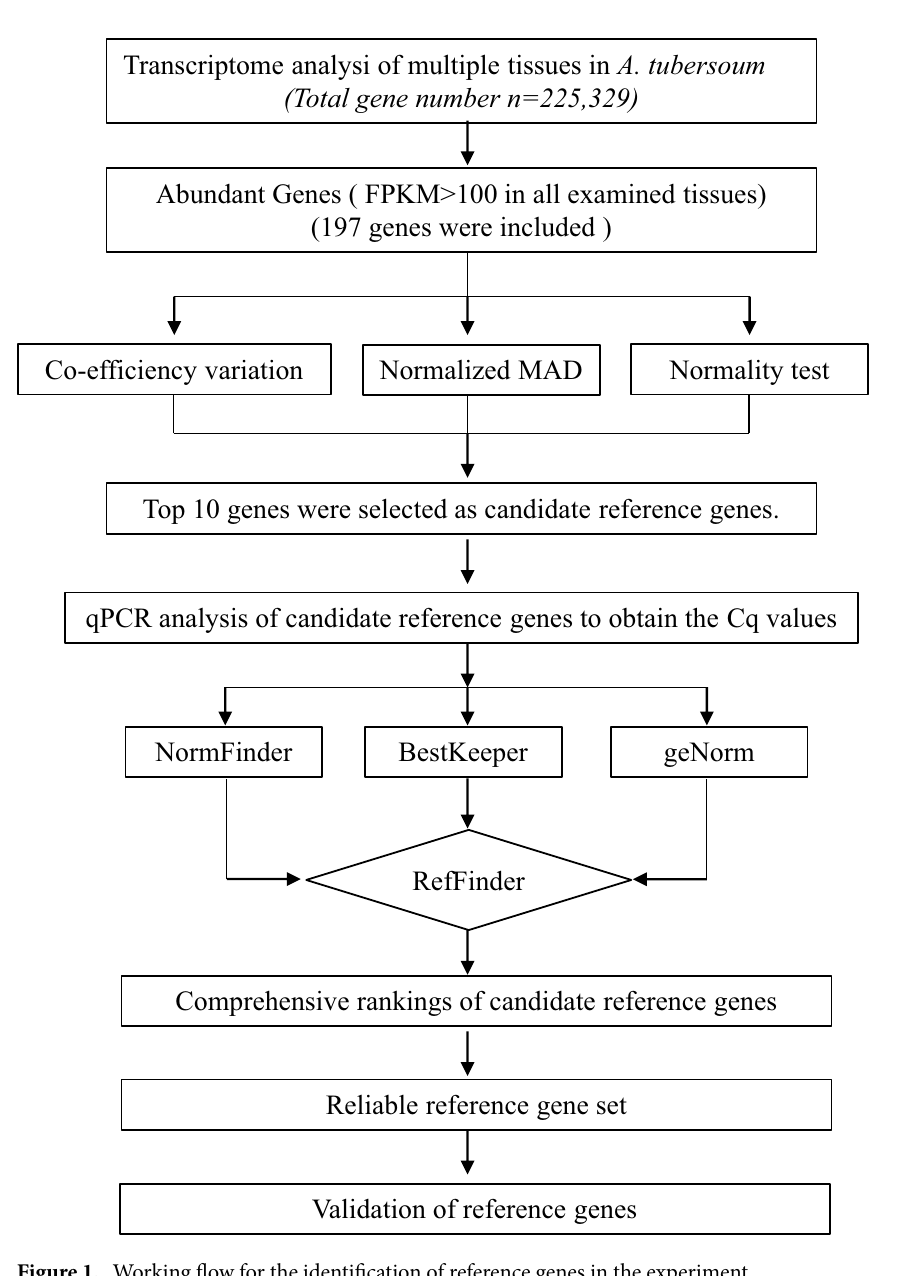
Figure 1. Working flow for the identification of reference genes in the